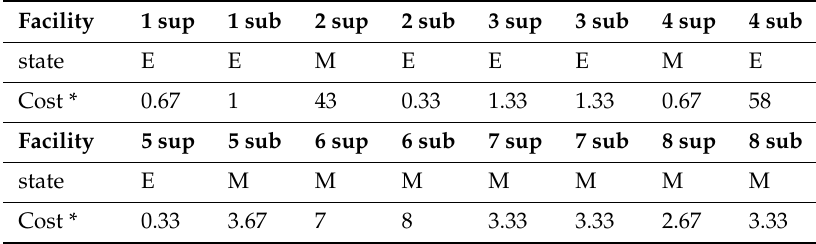
Table 11. Budget demand for the first year.